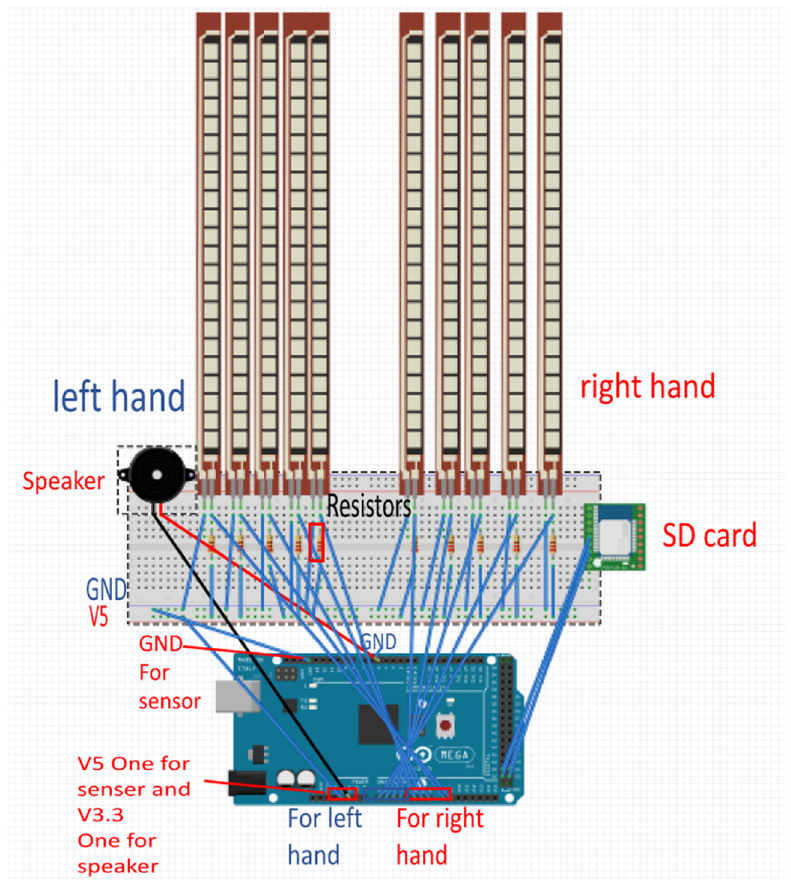
Figure 4: Circuit diagram of IG system.